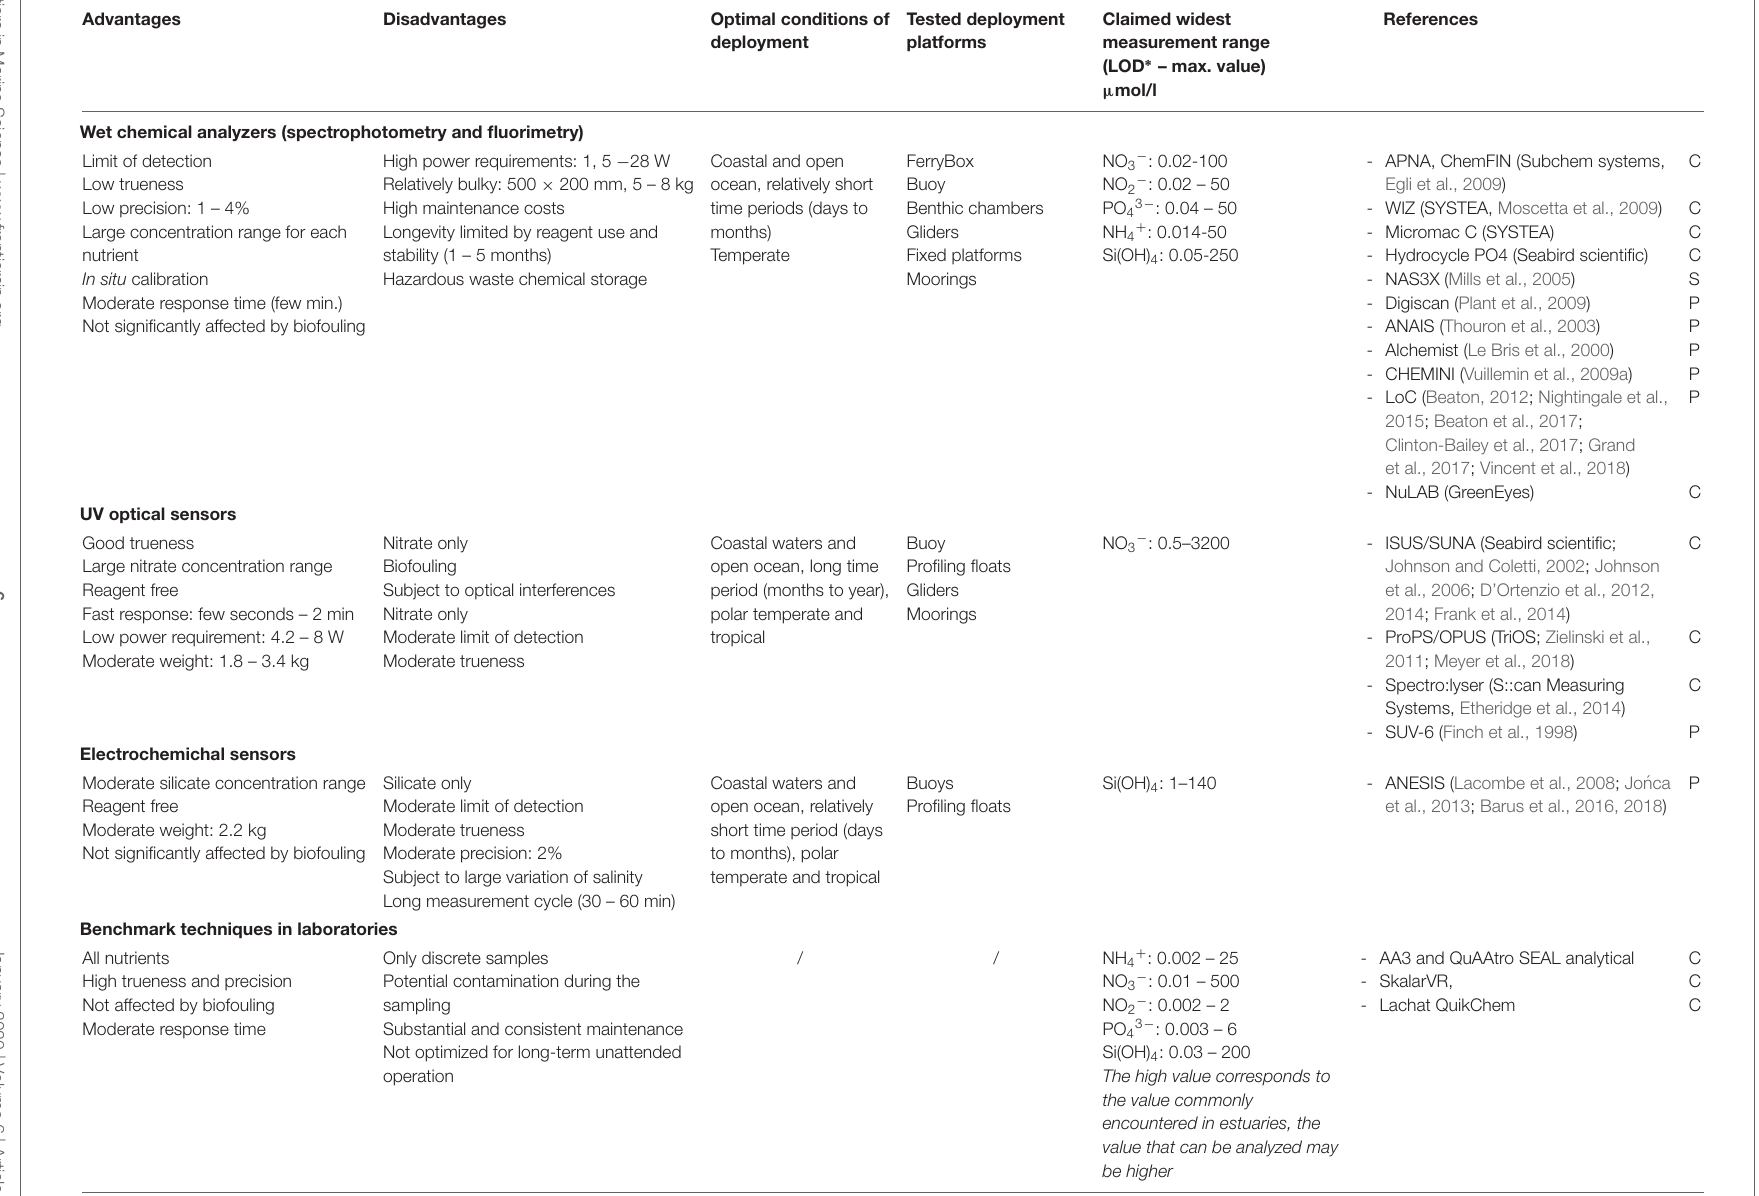
TABLE 2 | Advantages and disadvantages of the analytical technologies used for the in situ determination of nutrients in